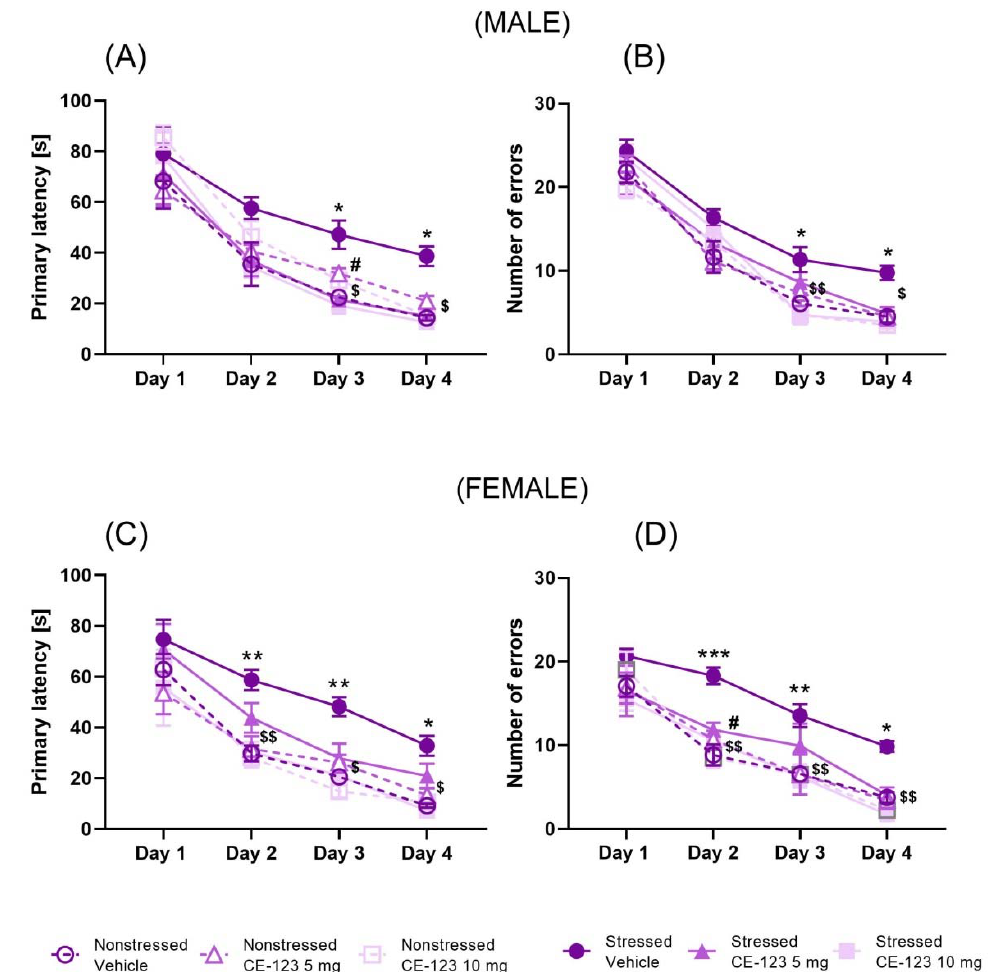
Figure 1. Effect of CE ‐ 123 (5 mg/kg and 10 mg/kg) or vehicle given each day before the acquisition session on the primary latency for males ( A ) and females ( C ) and number of errors for males ( B ) and females ( D ) committed during 4 days of the acquisition of spatial learning of the Barnes maze task in adolescent (PND30 ‐ 33) rats. Wistar rats were subjected to MS for 180 min during PND1 ‐ 21. Data represent mean ± SEM (N = 10 rats/group). * p < 0.05, ** p < 0.01, *** p < 0.001 Stressed/Vehicle vs. Nonstressed/Vehicle; # p < 0.05 Stressed/CE ‐ 123 5 mg/kg vs. Stressed/Vehicle; $ p < 0.05, $$ p < 0.01; Stressed/CE ‐ 123 10 mg/kg vs. Stressed/Vehicle; PND—postnatal day.